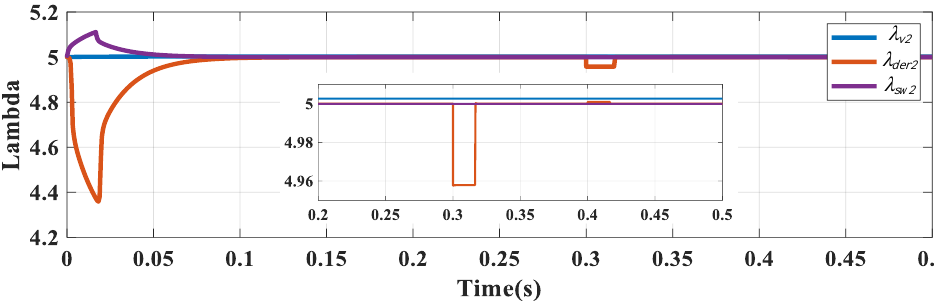
Figure 22. Study 3: generated weighting coefficients for FCS-MPC in DG2.